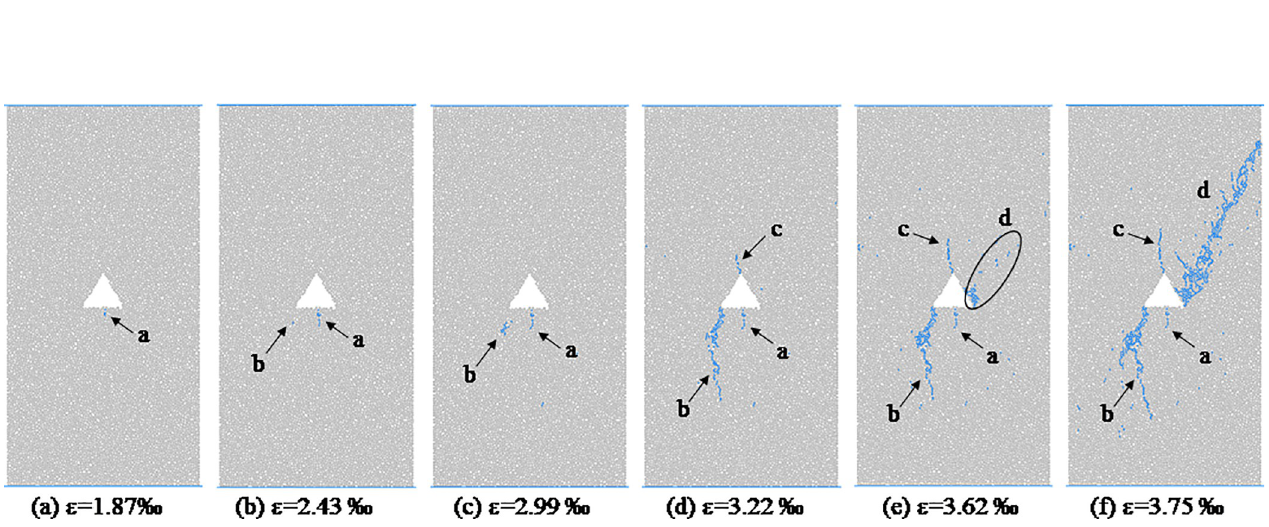
Fig 11. Meso-damage process of coal and rock with triangular hole defect.